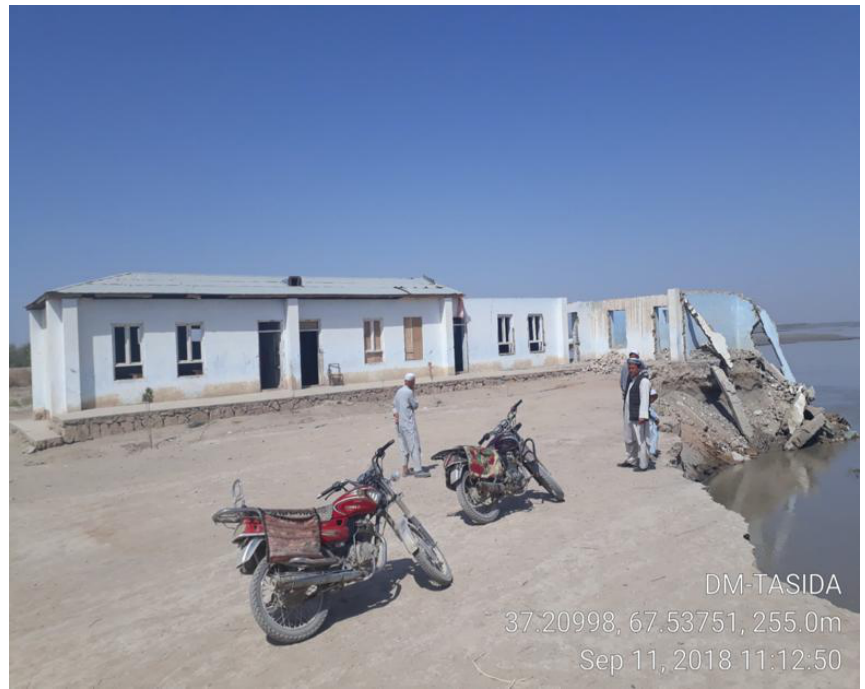
Figure 2. A school constructed in an Amu Darya river flood plain in Afghanistan and partially destroyed by flooding. This image was provided by Development Monitors